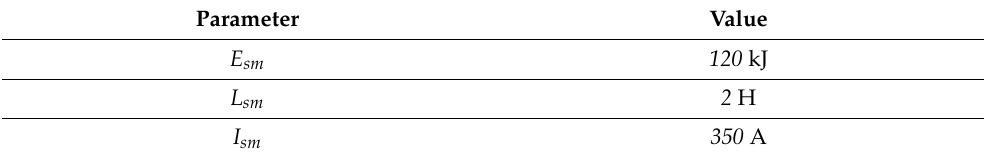
Table 4. The SMES system parameters.